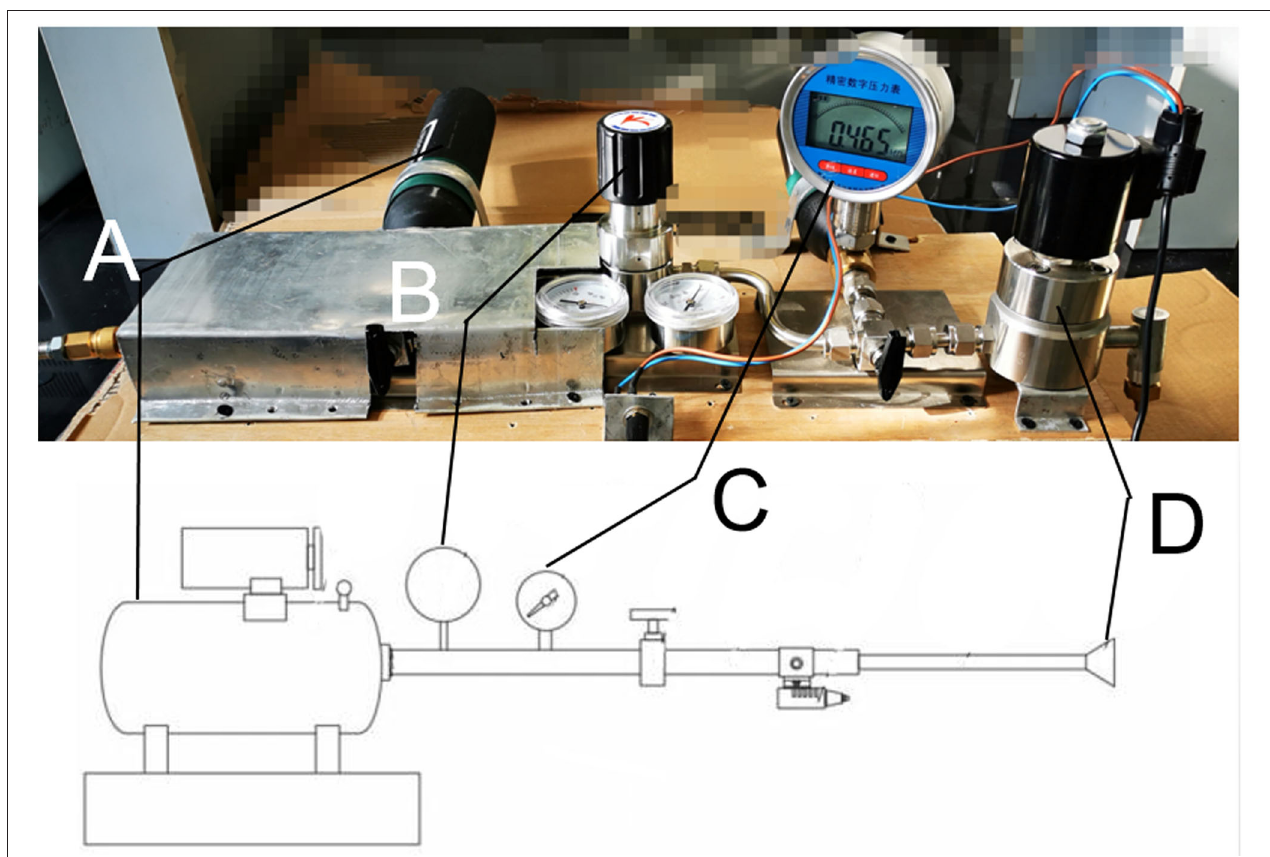
FIGURE 1 | Picture of the real blast device corresponding to the schematic diagram. (A) High-pressure air source generating device. (B) Pressure regulating valve. (C) Piezometer. (D) Nozzle.